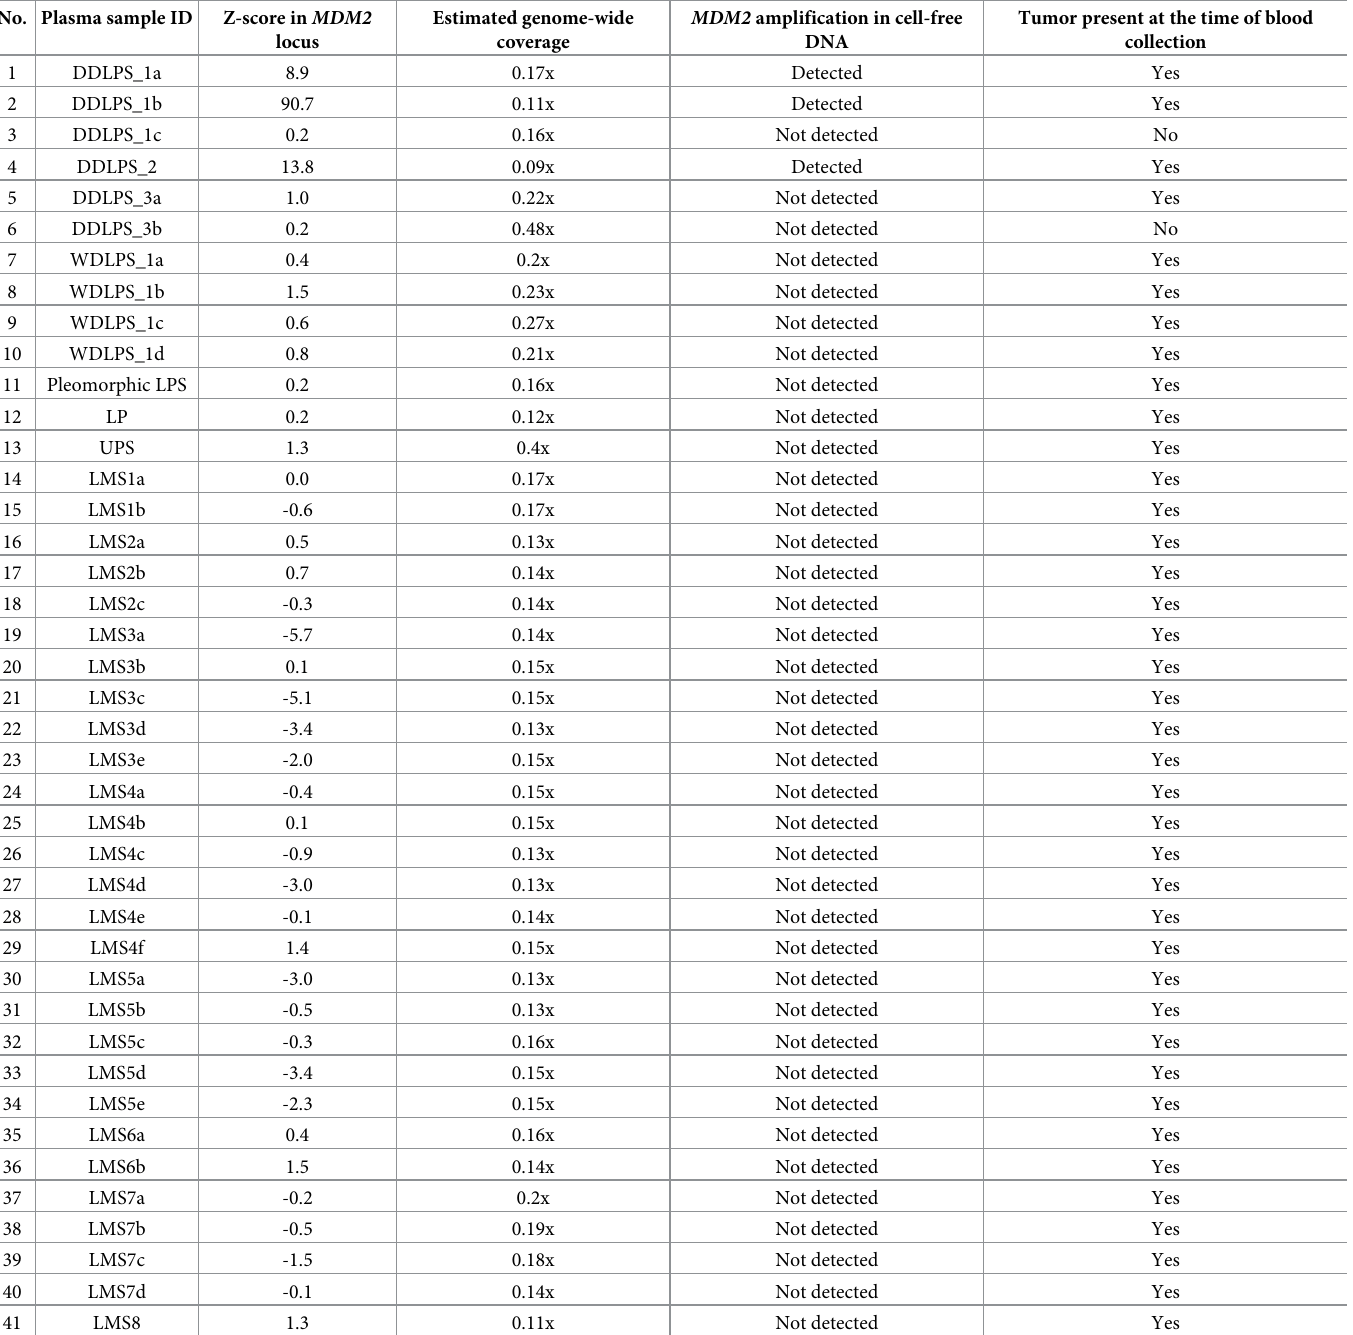
Table 2. Detection of MDM2 amplification in cell-free DNA of patients with different types of soft tissue tumors. No. Plasma sample